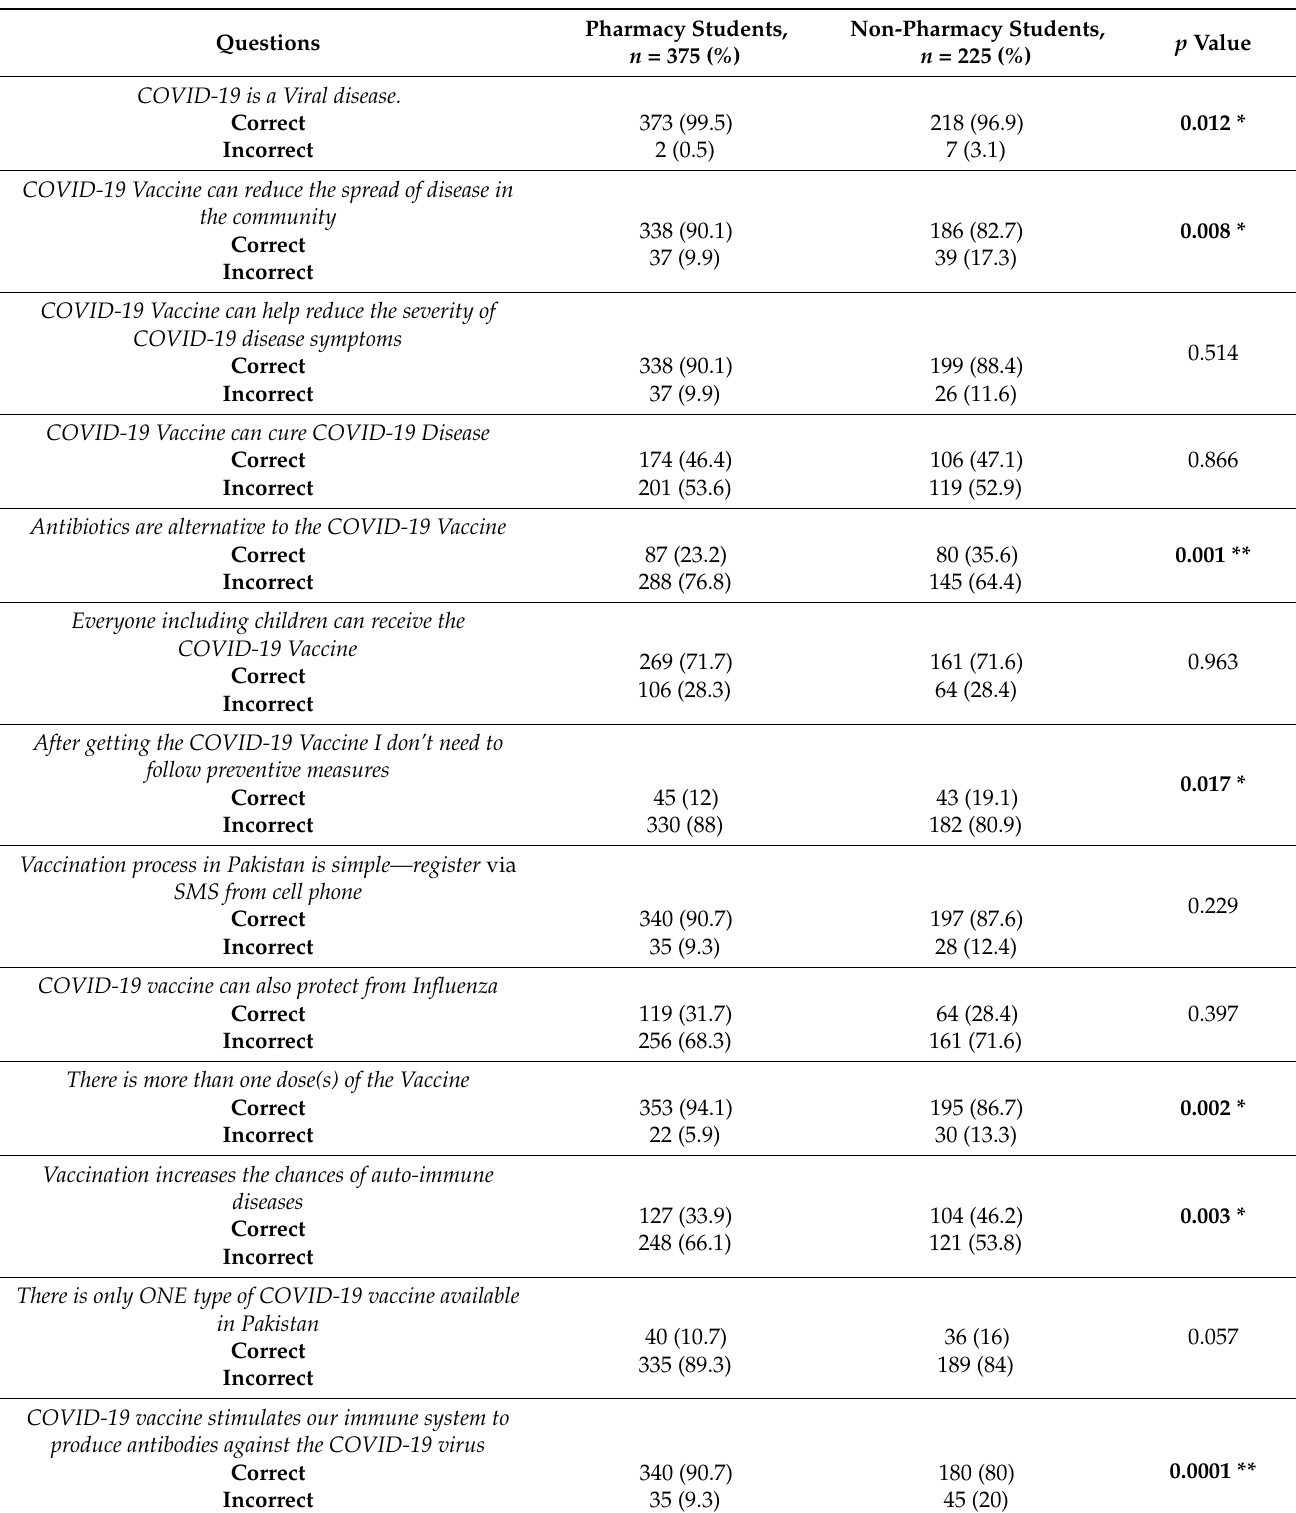
Table 3. Assessment of COVID-19 Vaccine’s Knowledge among Students, Pharmacy and